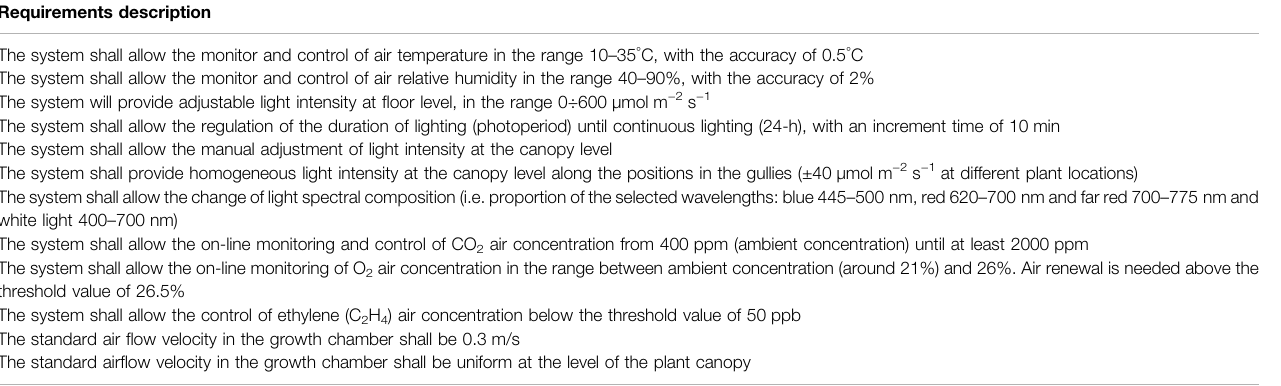
TABLE 3 | Requirements considered for the design of the atmospheric module of the